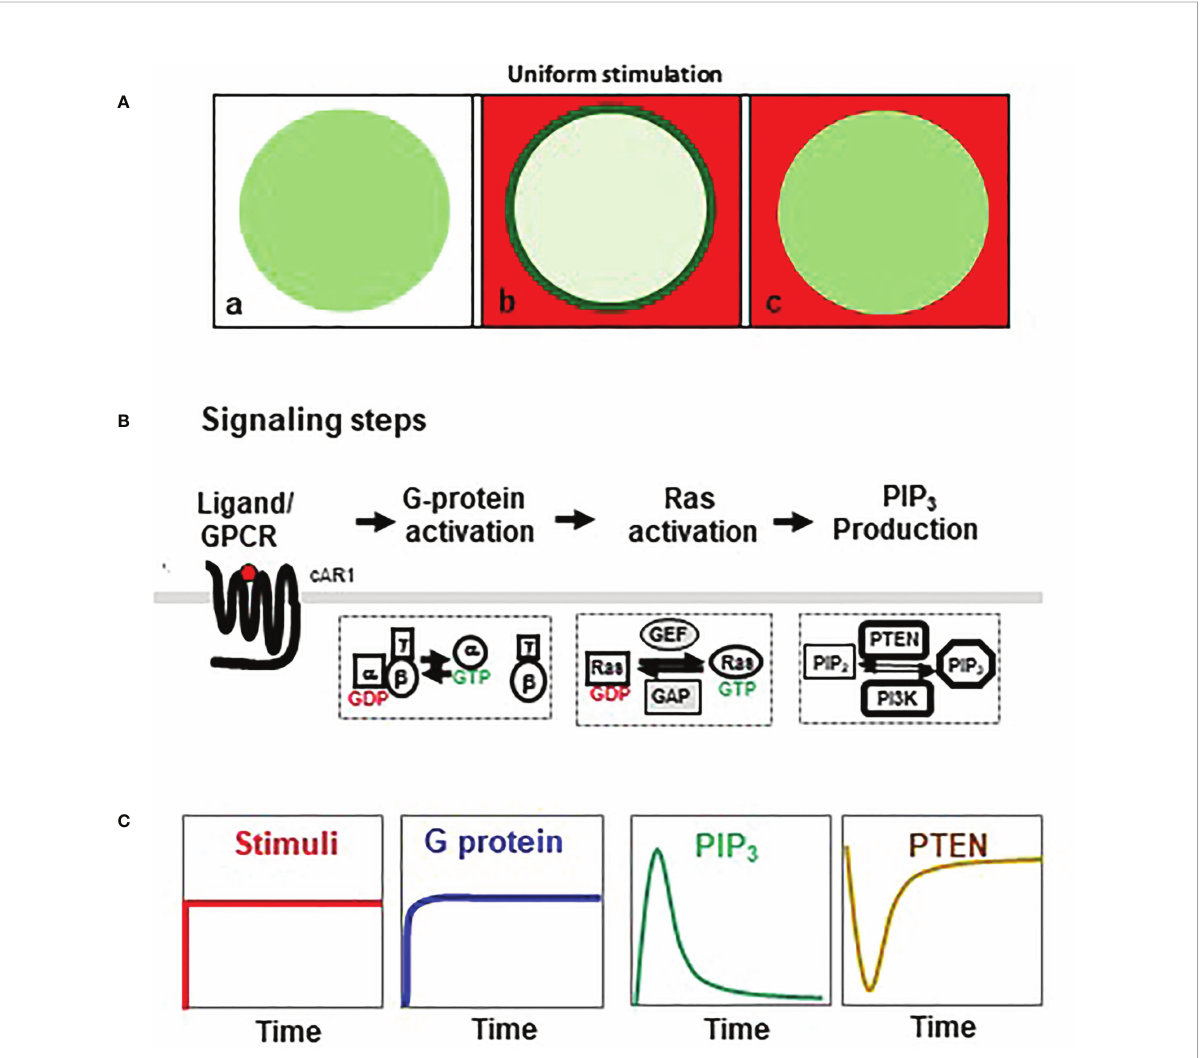
FIGURE 1 Adaptative activation of heterotrimeric G protein, Ras, and PI 3 K. (A) Homogeneouly applied (uniform) stimulation triggers a transient membrane translocation of a cytosolic protein in the cells. a, a resting cells expressing a cytosolic protein (green); b, cell is stimulated by uniform stimulation (red) and displays a response as membrane translocation of cytosolic protein to the plasma membrane (green); c, cell in adaptation, in which the cell ’ s response is terminated while still in the presence of the stimulus. (B) Simpli fi ed chemosensing signaling pathway, including activaiton of heterotrimeric G protein, Ras, PI3K, and PTEN in Dictyostelium discoideum . (C) Dynamics of chemoattractant concentration of chemoattractant, G protein activation, Ras activation, PIP 3 production, and membrane-bound PTEN upon uniform